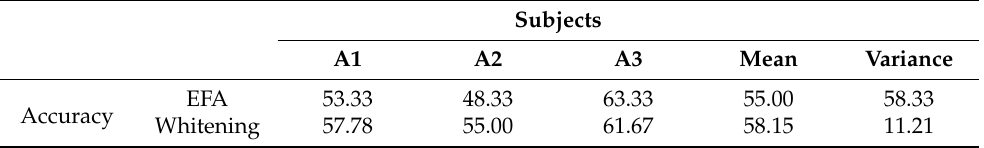
Table 4. Variance comparison according to classification methods for C3D3a_2C.